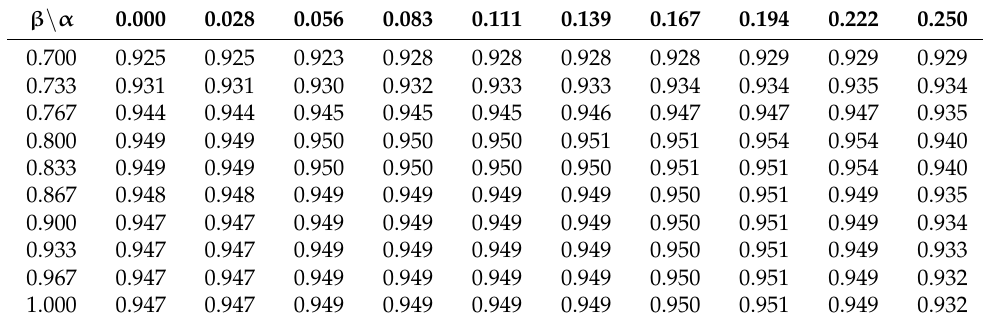
Table 7. Classification accuracy of the structure function building for different thresholds of α and β . β \ α